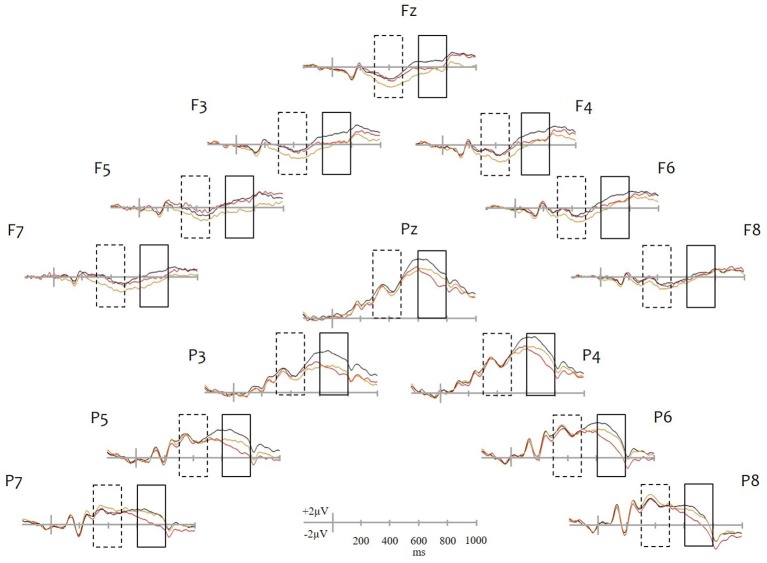
Grand average waveforms. ERP plots are shown for selected frontal (Fz, F3, F4, F5, F6, F7, F8) and parietal (Pz, P3, P4, P5, P6, P7, P8) sites. Recent hits are drawn in black, remote hits in red and correct rejections in yellow. Dashed and solid line rectangles identify the 300–500 ms and 600–800 ms periods, respectively, in which ERPs were analyzed. Note: With the exception of the two midline sites (Fz and Pz), all sites shown were included in the analyses.